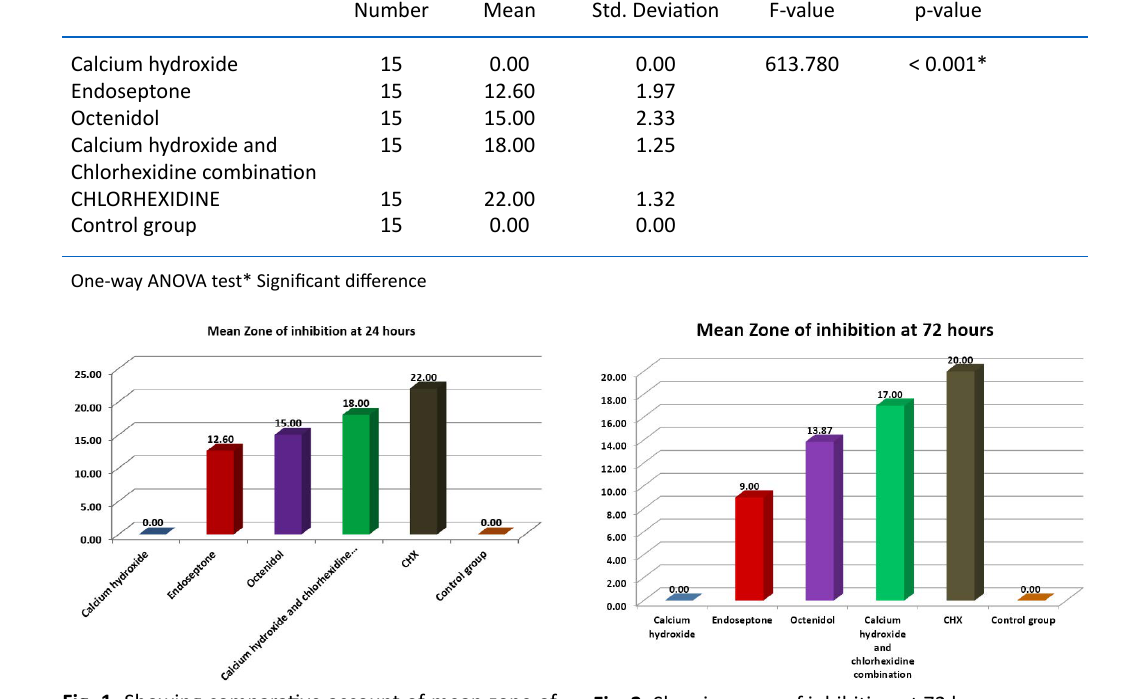
Table 1. The mean zone of inhibition at 24 hours Zone of inhibition at 24 hours Number Mean Std. Deviation